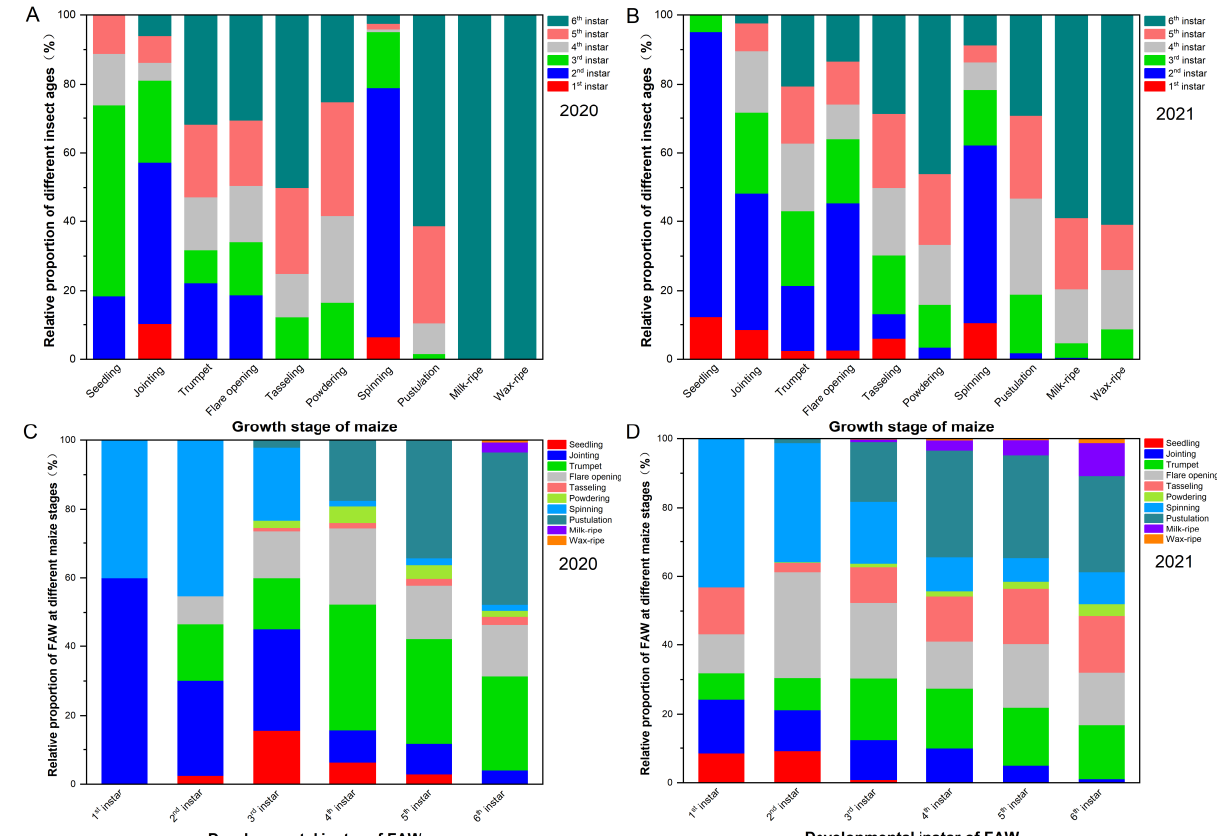
Figure 2. The relative damage proportions of S. frugiperda larvae (1 st instar to 6 th instar) in mountain maize fields across growth stages in ( A ) 2020 and ( B ) 2021, and the relative damage proportion of S. frugiperda larvae at different maize stages (from seedling stage to waxy stage) in mountain maize fields across the development instar of S. frugiperda larvae in ( C ) 2020 and ( D ) 2021.